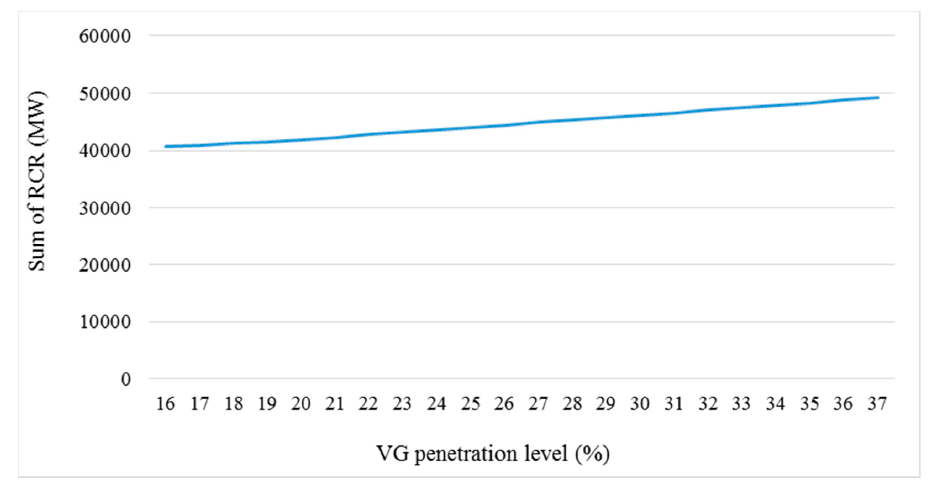
Figure 7. Sum of RC requirement ( RCR ) versus VG penetration level.